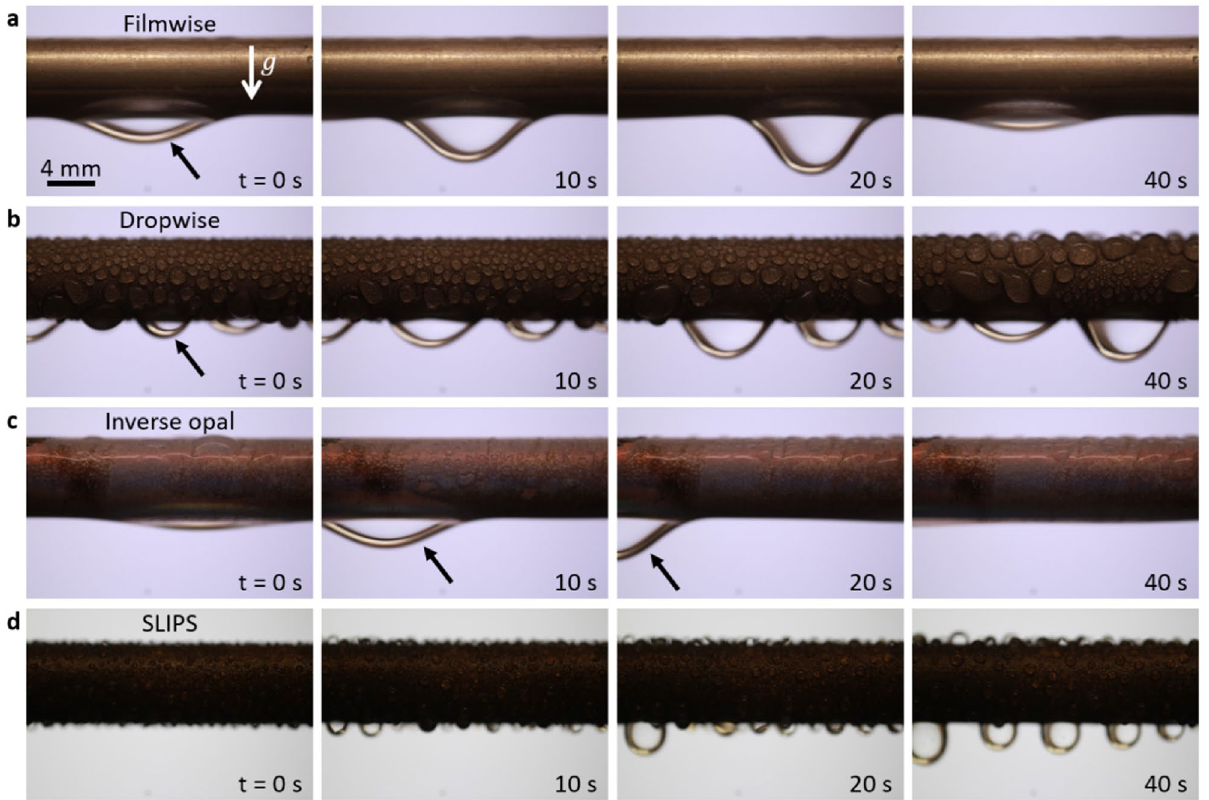
Figure 5. Time-lapse images of water condensation on copper tubes subject to varying surface treatments, showing different modes of condensation. ( a ) FWC on a smooth plasma treated copper tube, ( b ) DWC on smooth hydrophobized copper tube, ( c ) IOC on silica inverse opal-coated copper tube, and ( d ) SLIPS condensation on oil-impregnated porous structure. In all cases except IOC, condensate was drained vertically downwards when gravity overcame pinning forces. During IOC, however, the condensate was transported preferentially in the axial direction through the cracks. Depending on the geometry, size, and orientation of the crack, the condensate moved axially to the right or to the left, but never